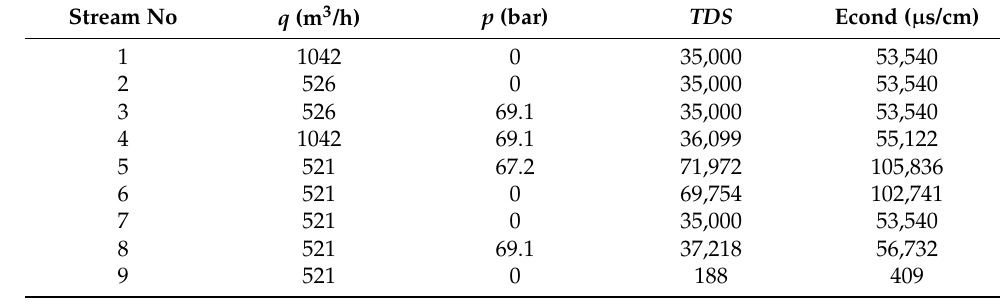
Table 2. RO streams information.